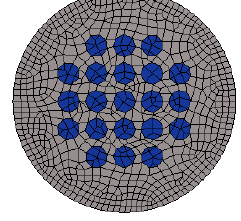
Fig. 8. Finite element discretization of the computational domain.